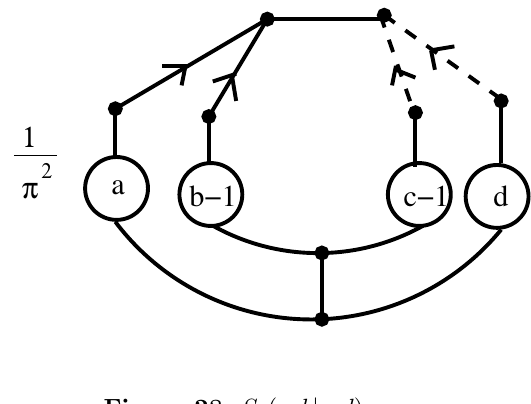
Figure 28 . S 1 ( a; b j c; d ).